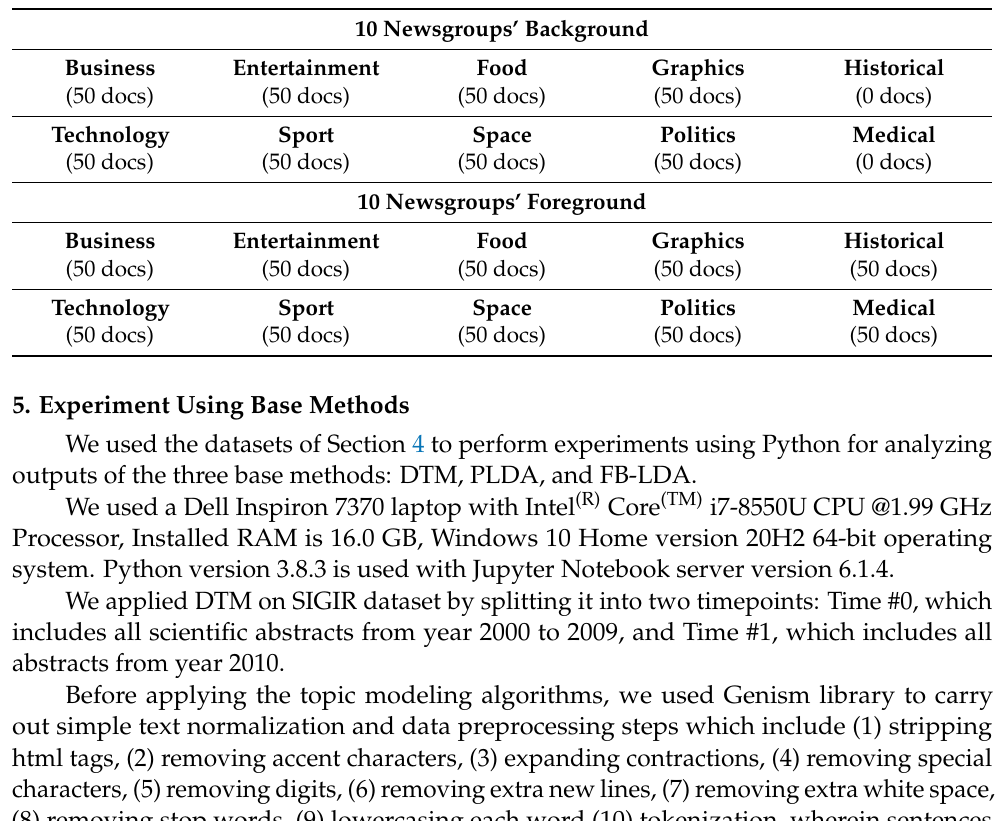
Table 2. Background and foreground of 10 Newsgroups